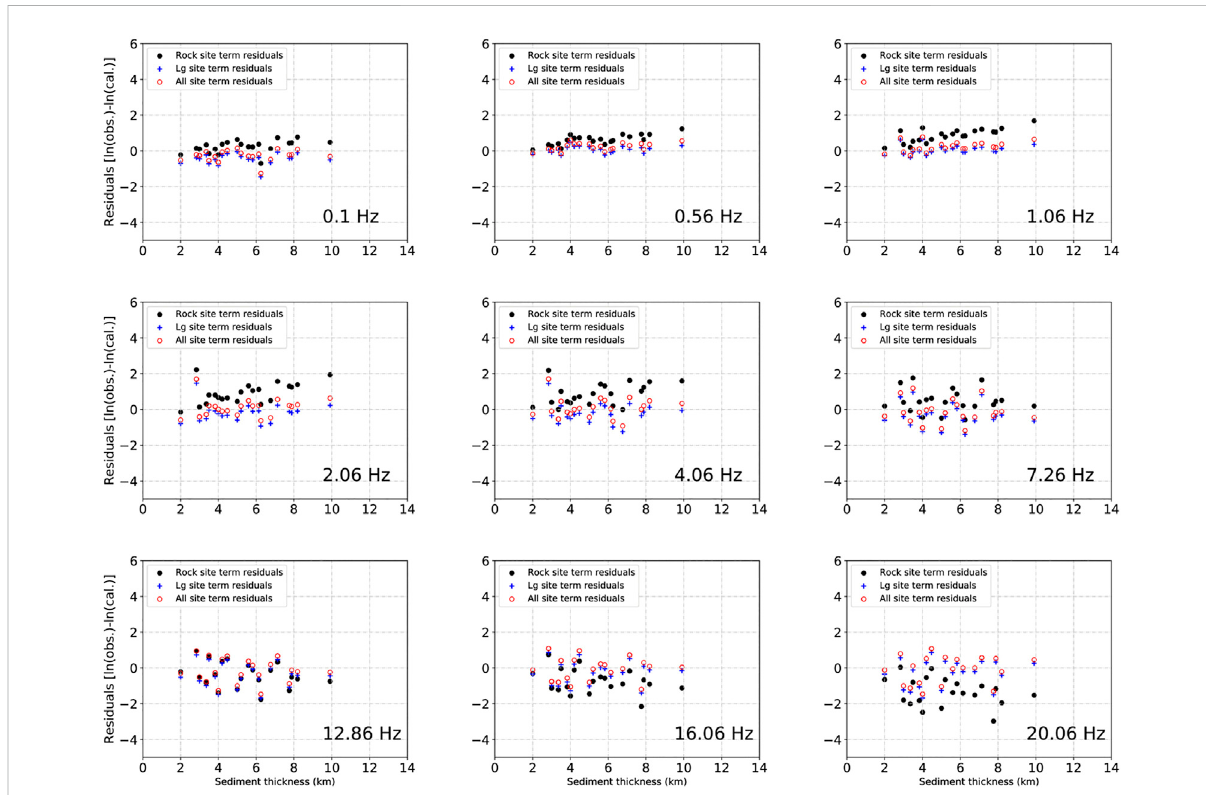
FIGURE 11 Rock site term residuals ( fi lled circles), Lg site term residuals (pluses) and all site term residuals (open circles) of stations in the Sichuan Basin at different frequencies plotted with respect to sediment thickness in the basin for the 1 June 2022 Ms 6.1 Lushan